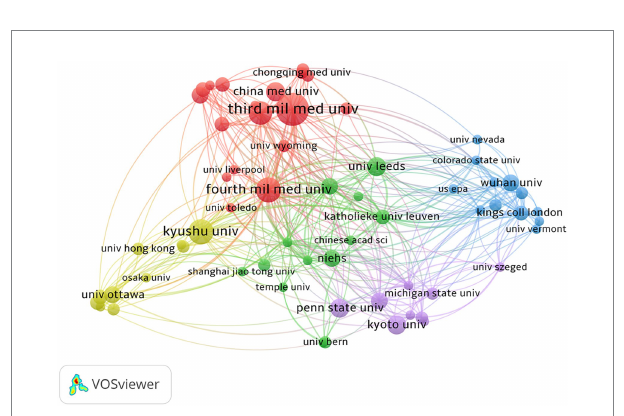
FIGURE 5 Co-authorship analysis of organizations. Co-authorship analysis of organizations showed by plots. It was normalized in the fractionalization method and weighted by the number of publications. The thickness of the lines indicates the strength of co-authorship relationships. Different clusters were painted in different